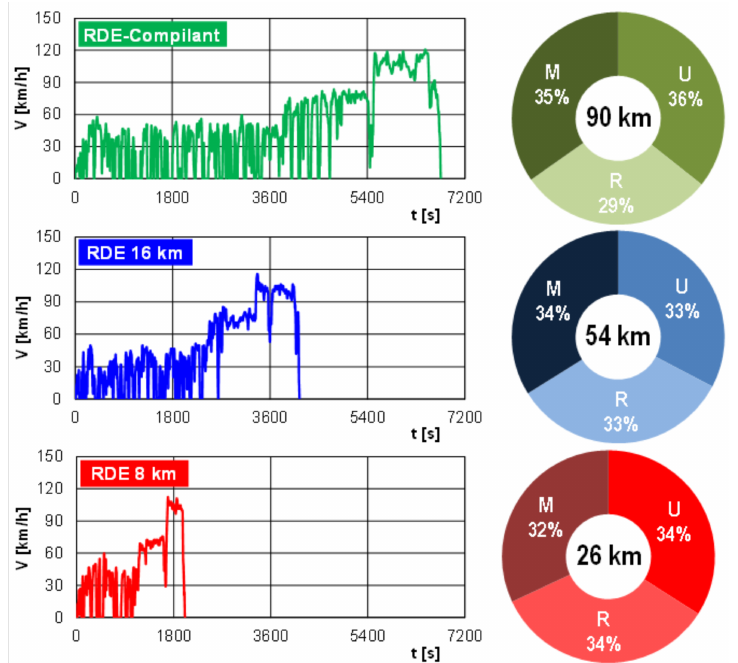
Figure 1. Velocity profile for each research test: RDE-Compliant, RDE 16 km and RDE 8 km, along with the percentages of each part in the entire test; U—Urban, R—Rural,